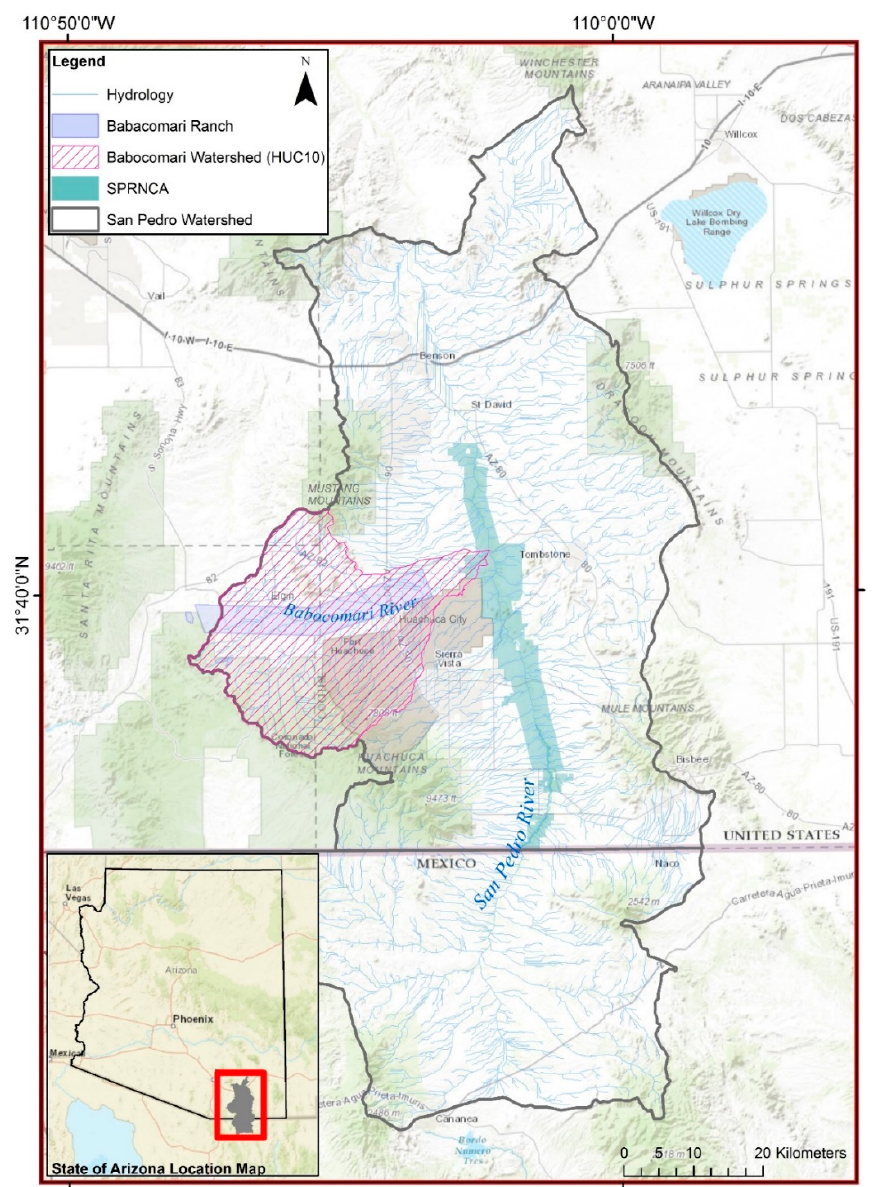
Figure 2. Location map depicting the San Pedro Watershed, in the State of Arizona and the US–Mexico border, cities, land ownership, and the Babocomari HUC10 sub-watershed.